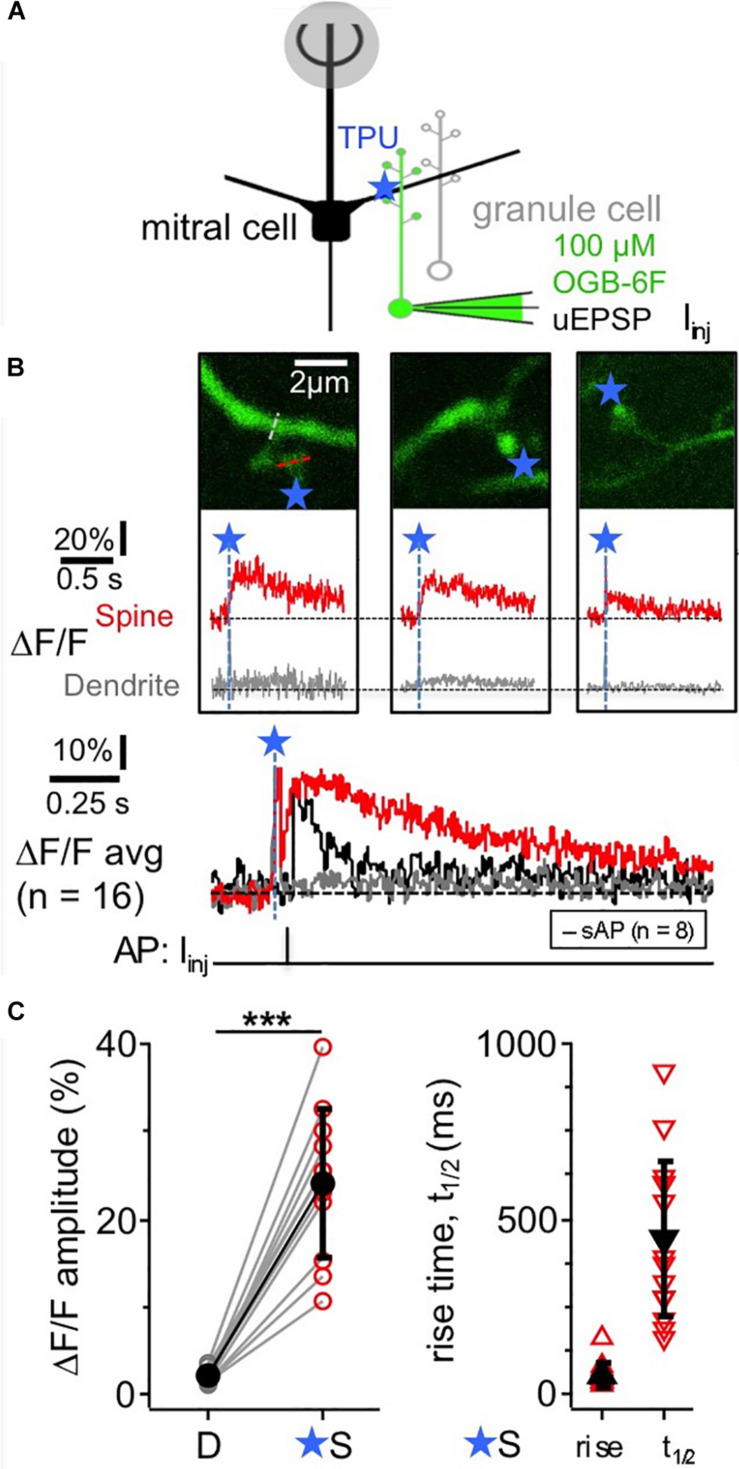
TPU-evoked Ca2 + entry into juvenile rat GC spines with low exogenous buffering. Imaging of TPU-evoked Ca2 + transients within GC spines with low exogenous buffering (100 μM OGB-6F). (A) Scheme of experiment: whole cell recording from GC (filled with dye via pipette) and TPU at spine head. The pipette was also used for brief current injections to evoke somatic APs (sAP). (B) Top: two-photon scans (z-projections) of three representative examples of individual spines filled with OBG-6F. Blue stars denote uncaging locations. Red and gray dotted line indicate line scan positions. Middle: respective averaged fluorescence transients (ΔF/F)TPU that were collected from line scans across the spine heads above (S, red) and the adjacent dendrite at the base of the spine neck (D, gray). Blue dashed lines and star: time point of uncaging. Bottom: (ΔF/F)TPU transients averaged across experiments (Ca2 + imaging: n = 11 spines) with the same time axis, spine response in red and dendrite response in gray. The black trace in the Ca2 + imaging graph represents the averaged response (ΔF/F)AP to a backpropragating somatically evoked AP (recorded in n = 8 of the 11 spines). (C) Cumulative plots of (ΔF/F)TPU amplitudes in dendrite and spine pairs (highly significantly different: P < 0.001, Wilcoxon test), and of rise times and half durations t1/2 of (ΔF/F)TPU within the spine heads (mostly not detectable in the dendrites).